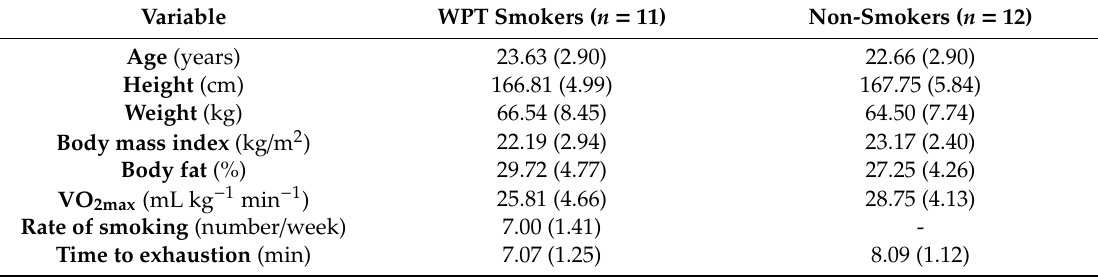
Table 1. Descriptive characteristics of waterpipe tobacco (WPT) smoker and non-smoker young